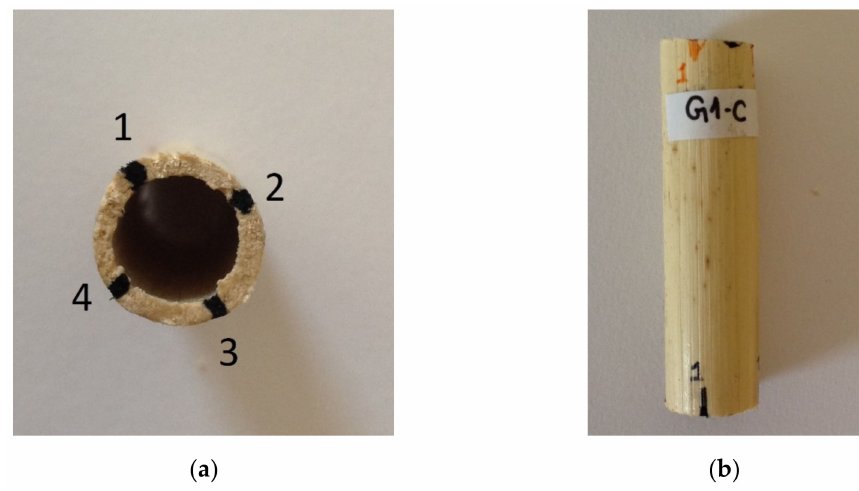
Figure 3. Markings used in the reeds to carry out the retraction test: ( a ) diameter and ( b ) length.